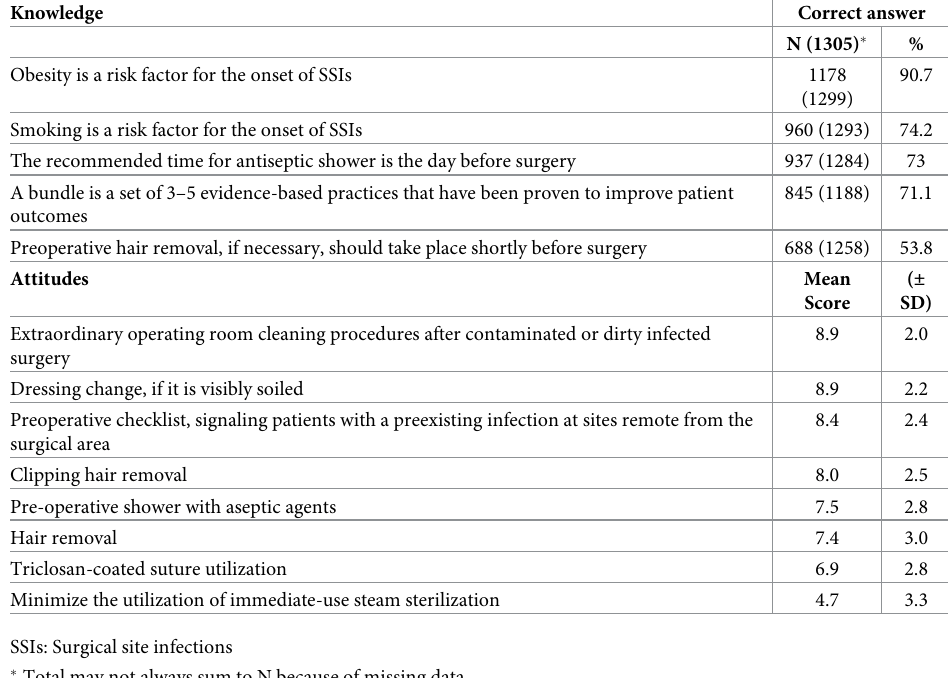
Table 1. Nurses’ knowledge of and mean score of attitudes toward